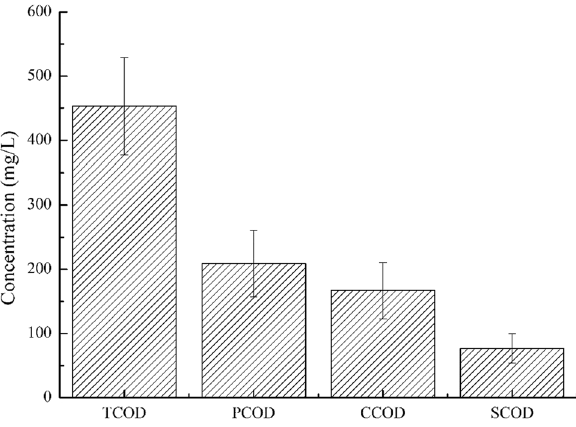
Figure 4. PCOD, CCOD and SCOD components concentration of wastewater